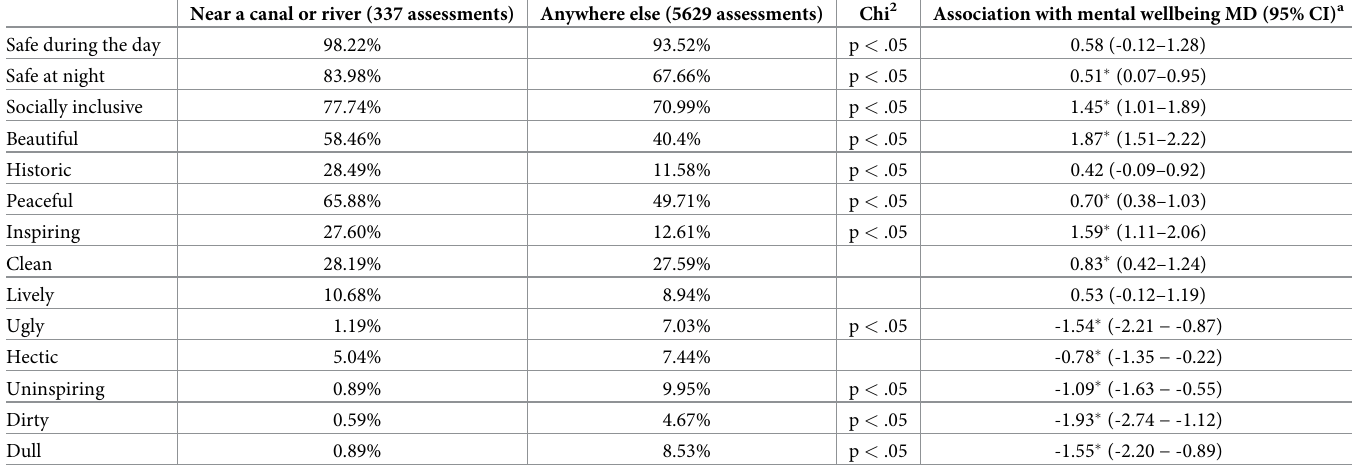
Table 4. Description of how people reported experiencing visiting canals and rivers versus being anywhere else and their association with mental wellbeing using the 50% completion threshold. Near a canal or river (337